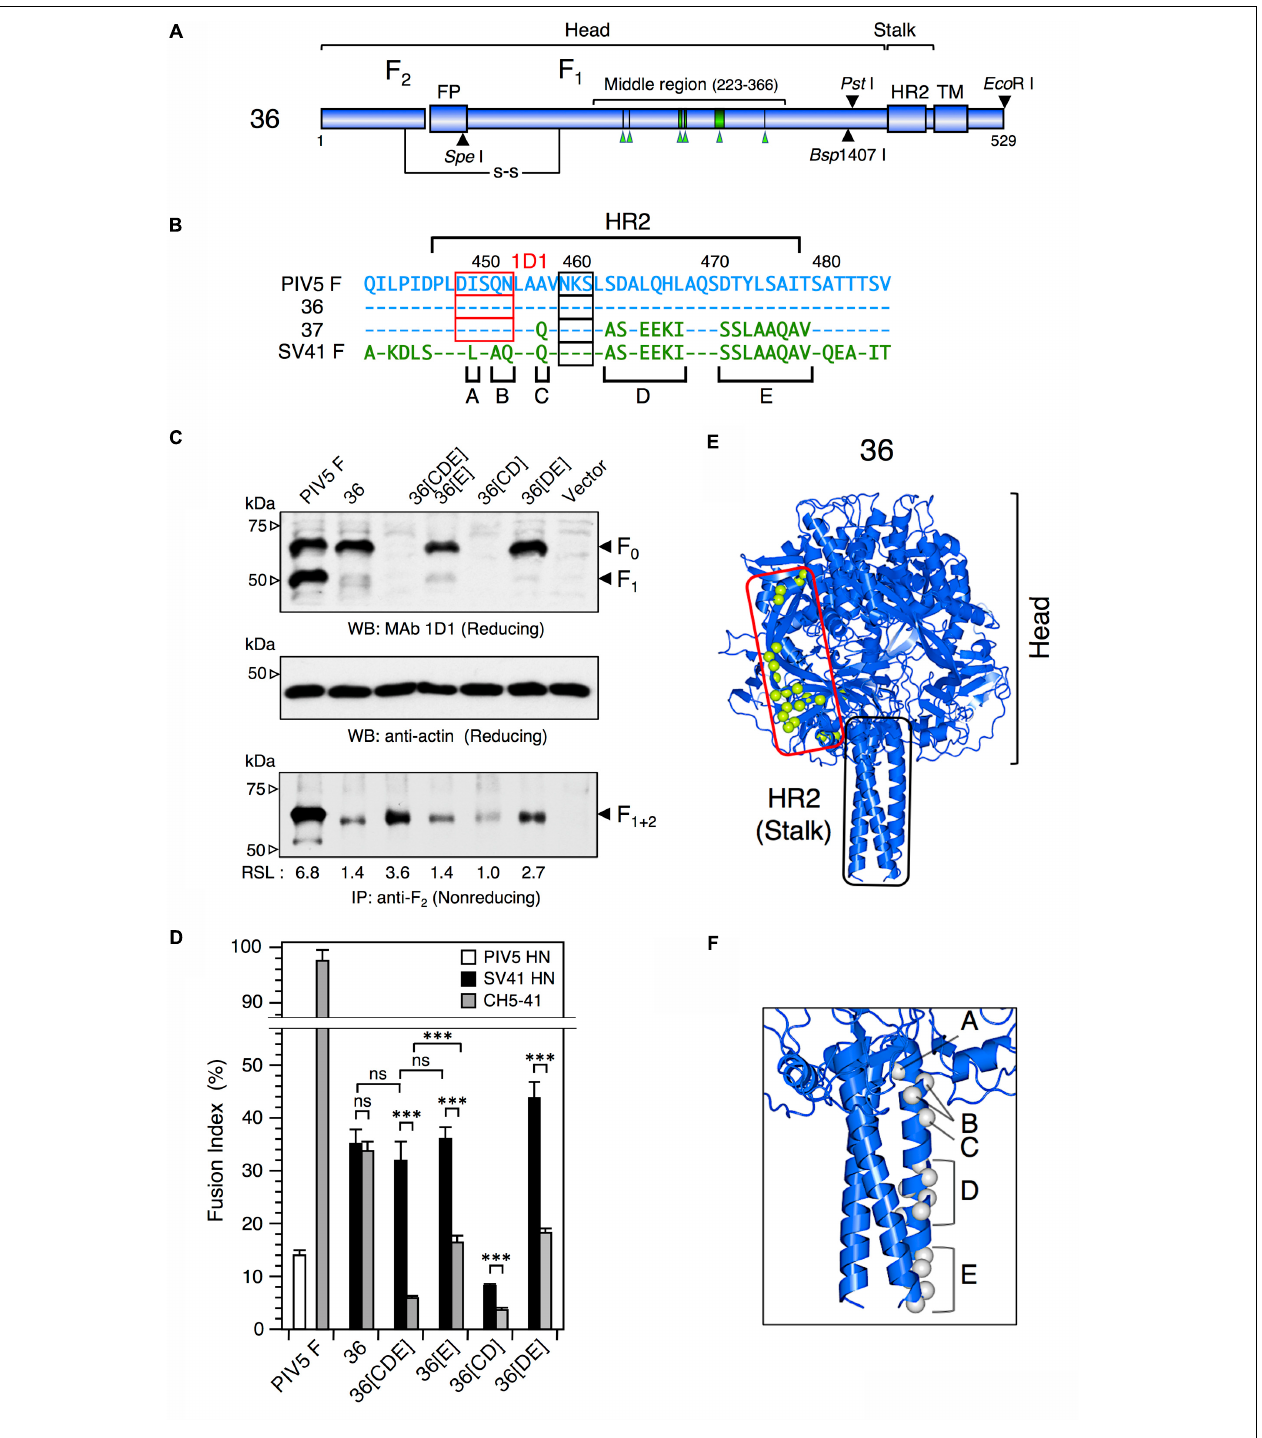
FIGURE 2 | The F stalk domain modifies the HN protein specificity. (A) Schematic diagrams of the chimeric F protein, no. 36. Blue cylinders represent regions derived from the PIV5 F protein. Six green arrowheads below the middle region indicate the positions of SV41 F-derived 21 amino acids. Filled triangles indicate the positions of restriction enzyme sites in the no. 36-encoding cDNA. TM, transmembrane domain; FP, fusion peptide; HR2; heptad repeat 2. (B) Amino acid sequence alignment of the HR2 domains of the PIV5 F protein, no. 36, no. 37, and the SV41 F protein. Dashes in the no. 36, no. 37, and the SV41 F sequences indicate the amino acids identical to the PIV5 F counterparts. The amino acids that are not shared by no. 36 (or the PIV5 F protein) and the SV41 F protein are grouped into five clusters (A, B, C, D, and E). Potential N -glycosylation sites are boxed. The core epitopes for MAb 1D1 are shown as red boxes. (C) Detection of the F proteins in the